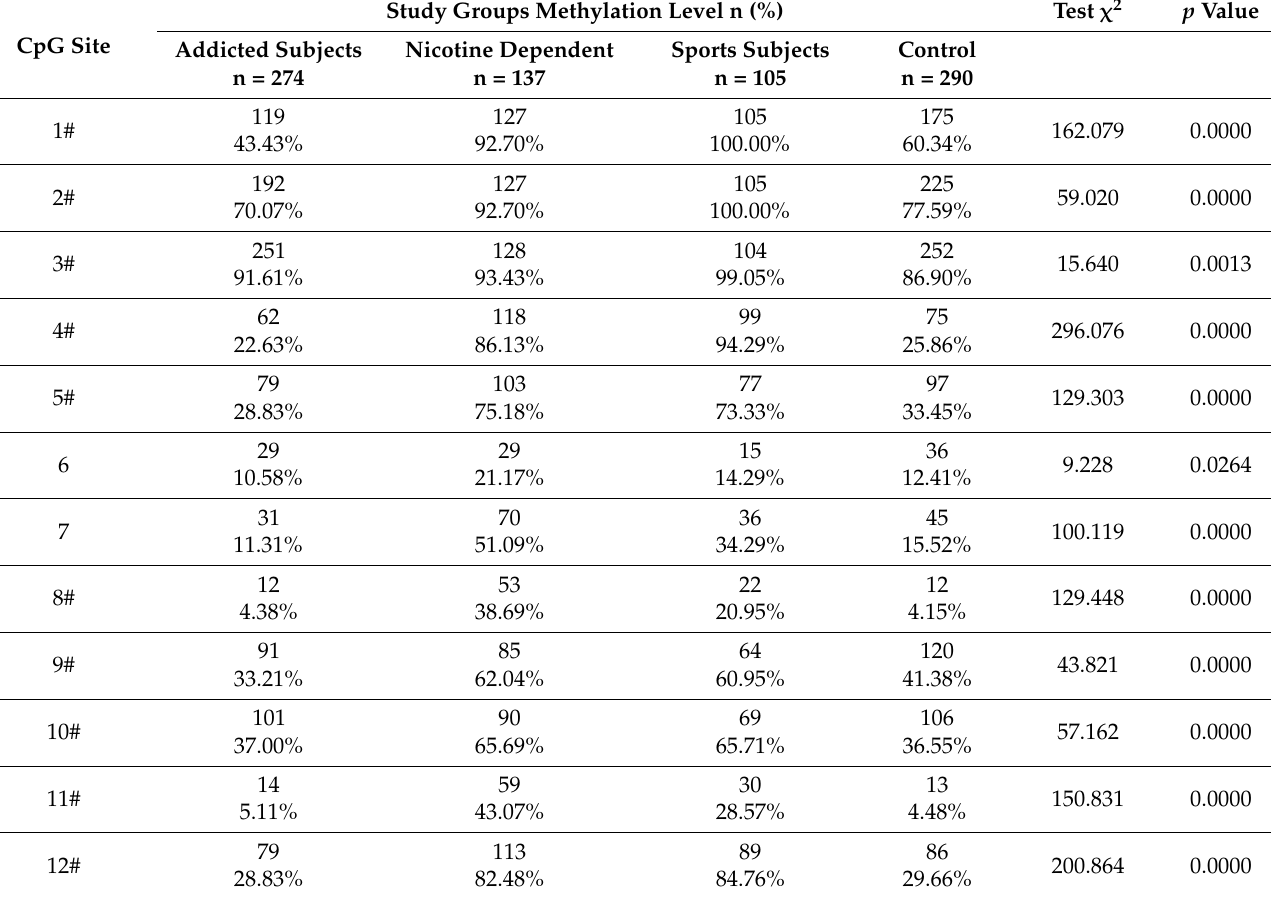
Table 1. Methylation status of 33 CpG DAT1 sites in the addicted, nicotine-dependent and sports subjects. 274 addicted, 137 nicotine-dependent, 105 sports and 290 control subjects were tested to compare the methylation status at the indicated CpG